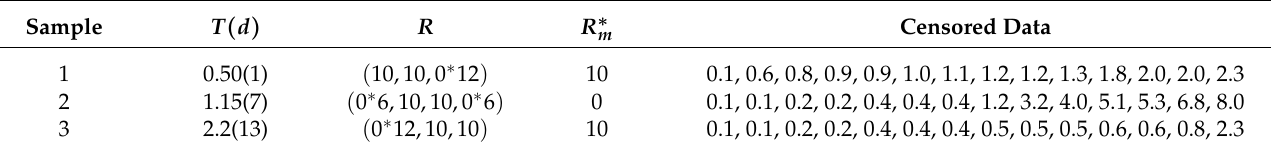
Figure 13. The QQ plots of the XL and competing models from vinyl chloride data. Table 5. Different generated samples from vinyl chloride